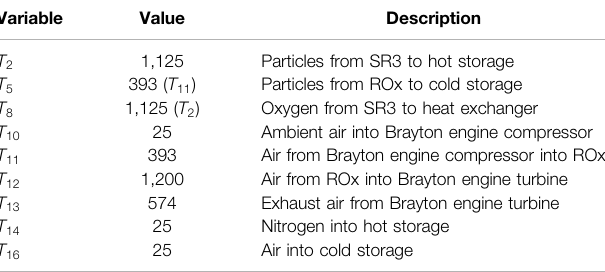
TABLE 2 | Fixed temperatures ( °